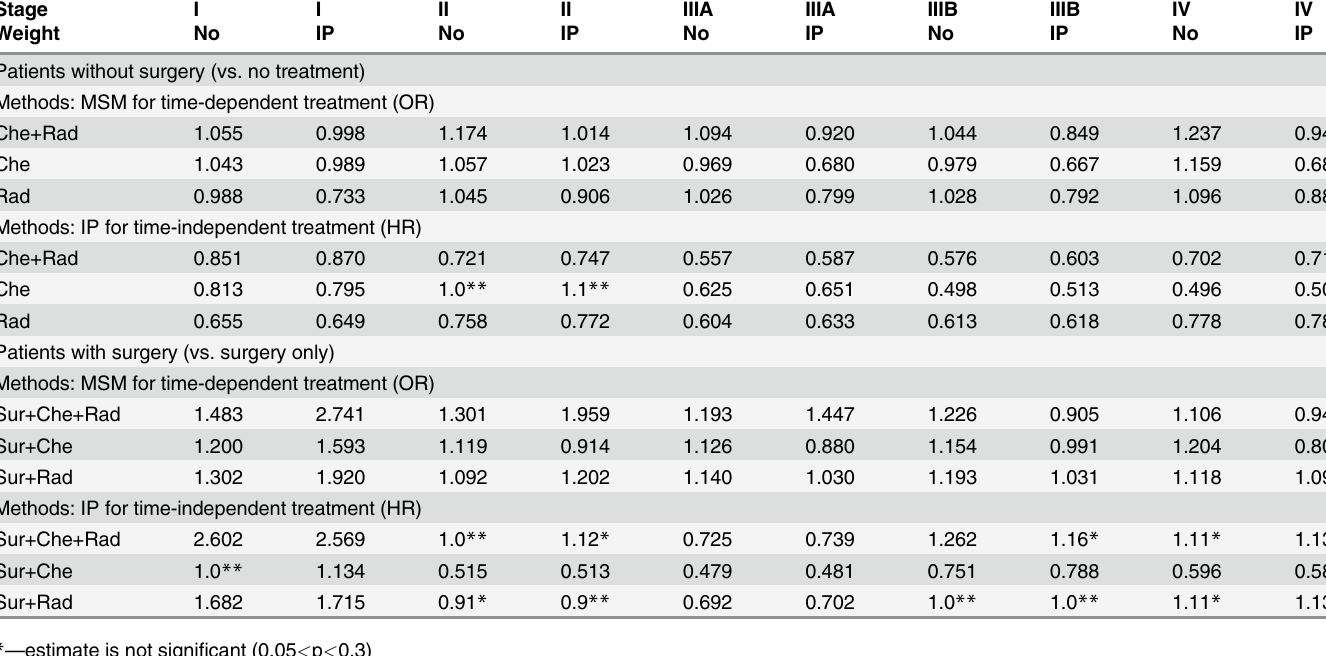
Table 4. MSM estimates for two treatment groups (involving and not involving surgery) of lung cancer patients represented by ORs and respective IPW estimates for time-independent treatments represented by